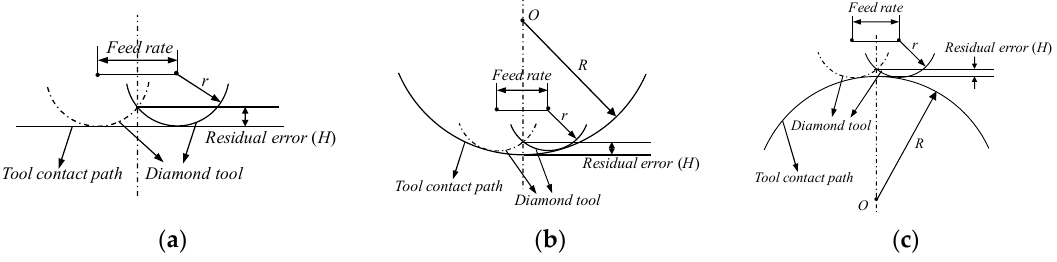
Figure 16. Illustration of cutting residual error. ( a ) Zero curvature surface processing; ( b ) Positive curvature surface machining; ( c ) Negative curvature surface fabricating.